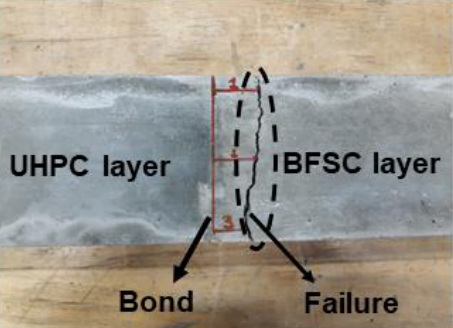
Figure 12. Failure mode of the vertically casted hybrid concrete (U1C2) after three-point bending test.